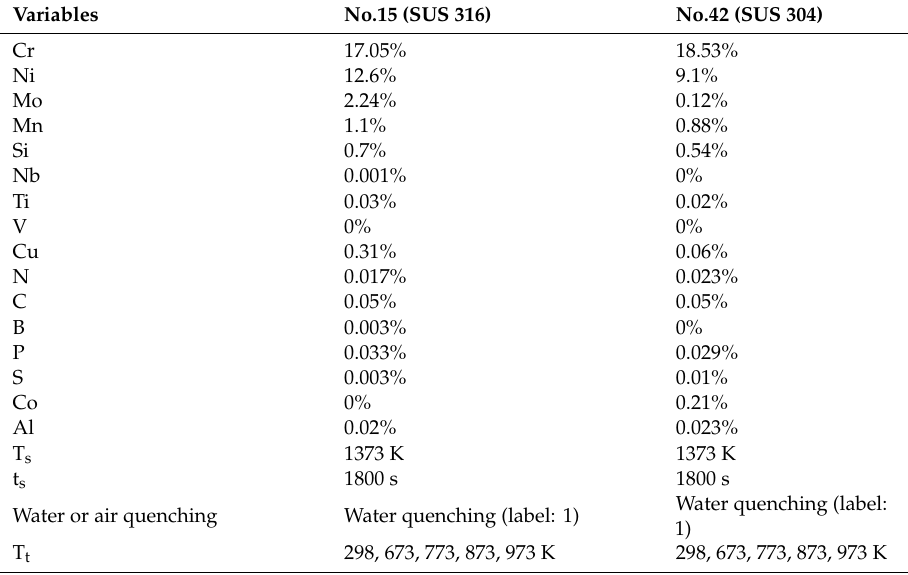
Table A3. The variables of new unseen data of austenitic stainless